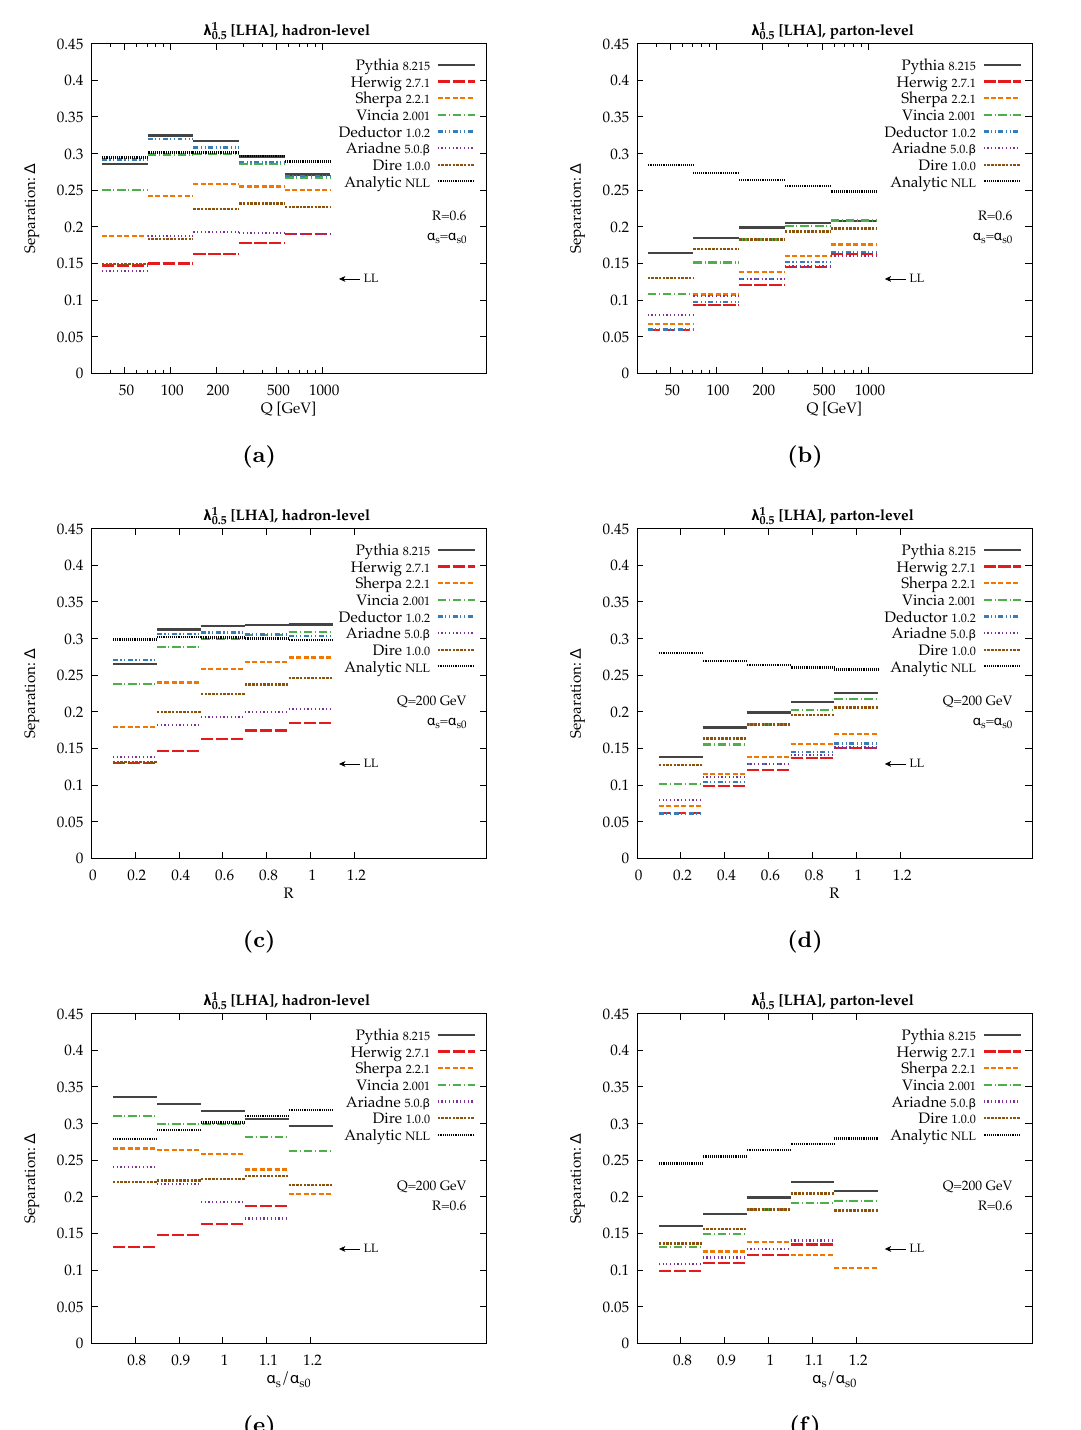
Figure 8. Classi(cid:12)er separation (cid:1) for the LHA, sweeping the collision energy Q (top row), jet radius R (middle row), and coupling constant (cid:11) s =(cid:11) s 0 (bottom row). Results are shown at hadron level (left column) and parton level (right column).